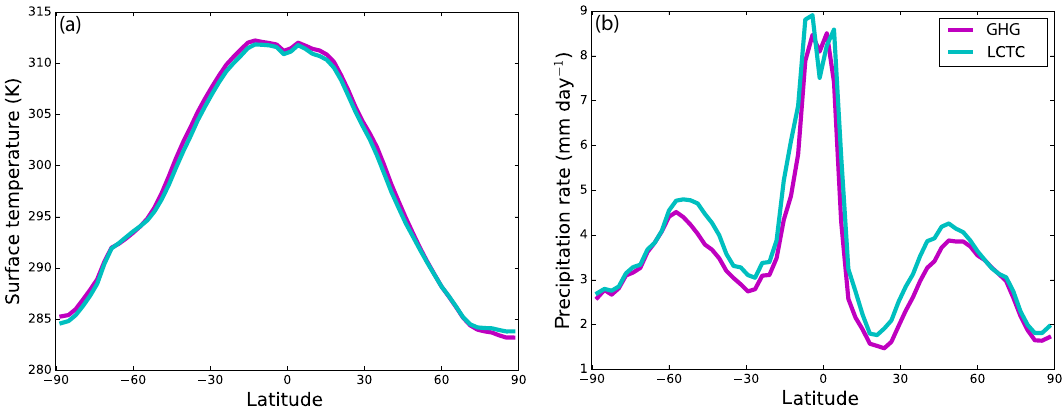
Figure 1. Annual- and zonal-mean surface temperature (a) and precipitation (b) in the GHG case (magenta) and LCTC case